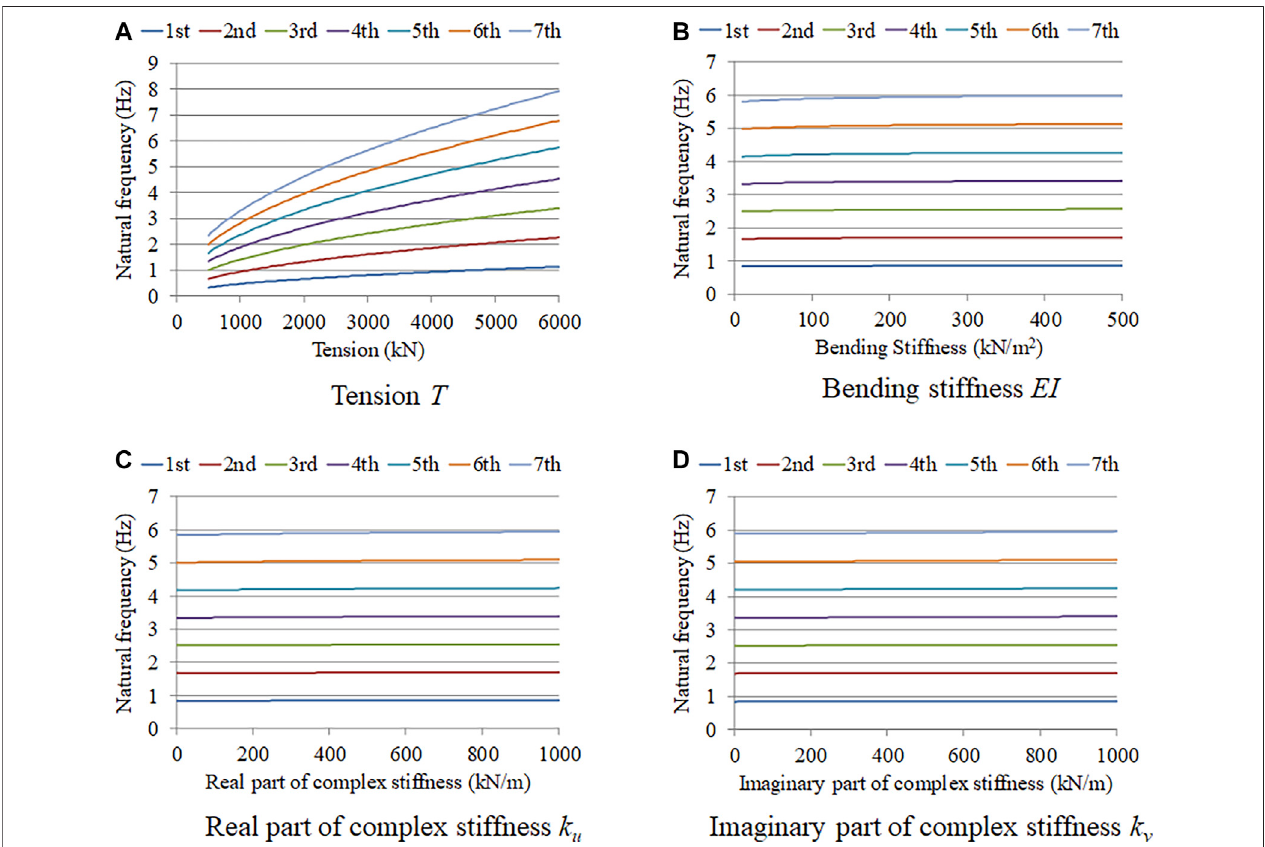
FIGURE 7 | Sensitivity analysis results for high-damping rubber damper: (A) tension; (B) bending stiffness; (C) real part of complex stiffness; (D) imaginary part of complex stiffness.